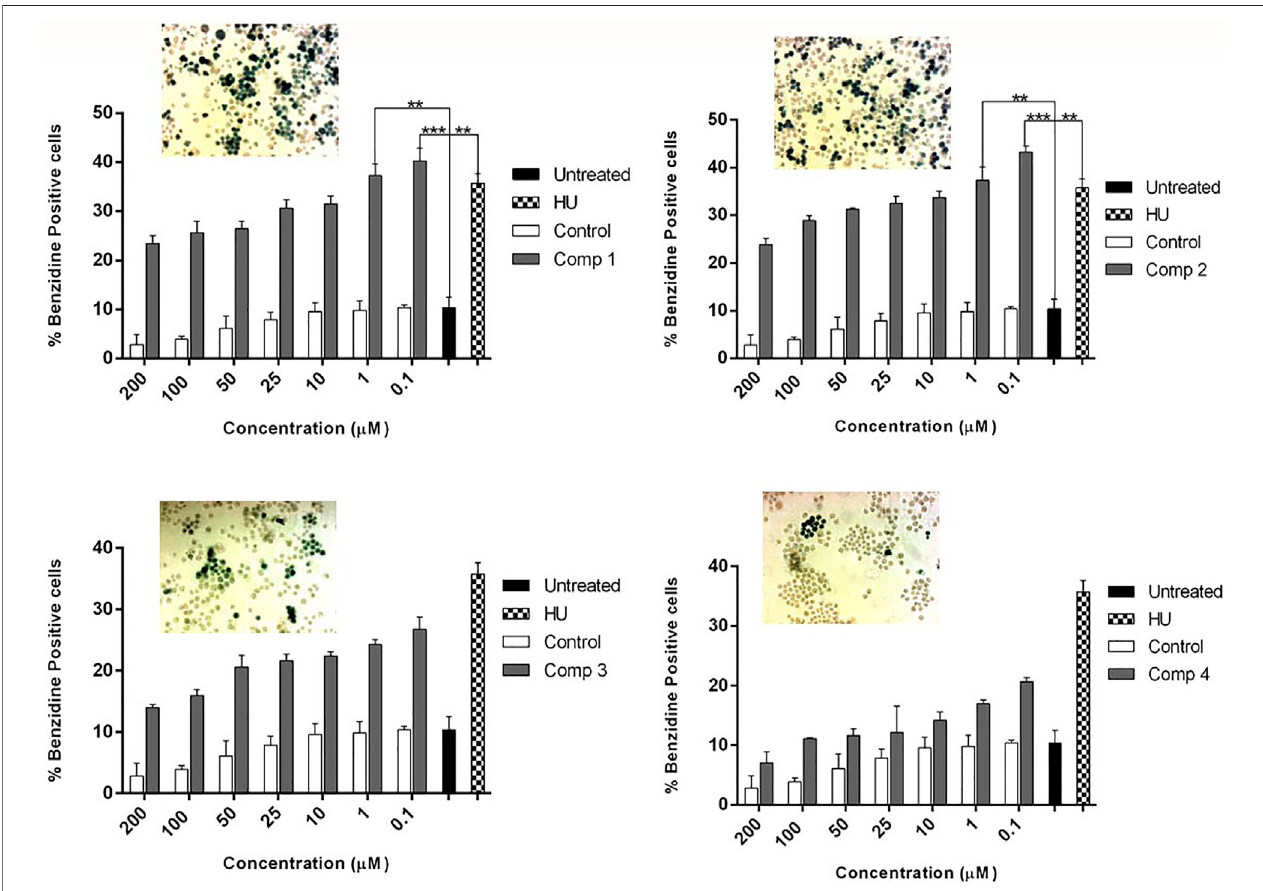
FIGURE 4 | K562 cells were treated with pure compounds of A. vasica in a concentration-dependent manner to assess the erythroid differentiation and induction by benzidine – Hb assay. Cells were harvested on day 5 after and the proportion of benzidine-positive (hemoglobin-containing) cells was calculated. Data shown are representative of three independent experiments and represented as mean ± SEM; * p < 0.05 was considered statistically signi fi cant vs. untreated cultures.